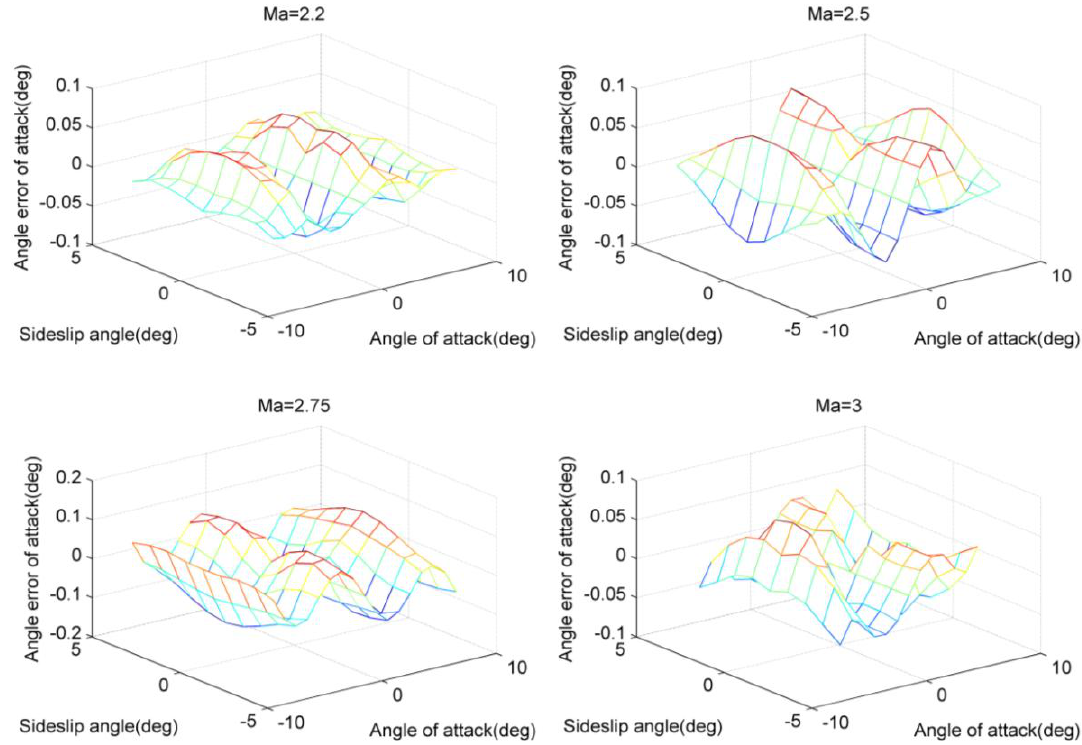
Figure 4. Change curves of angle errors of attack using least squares method.